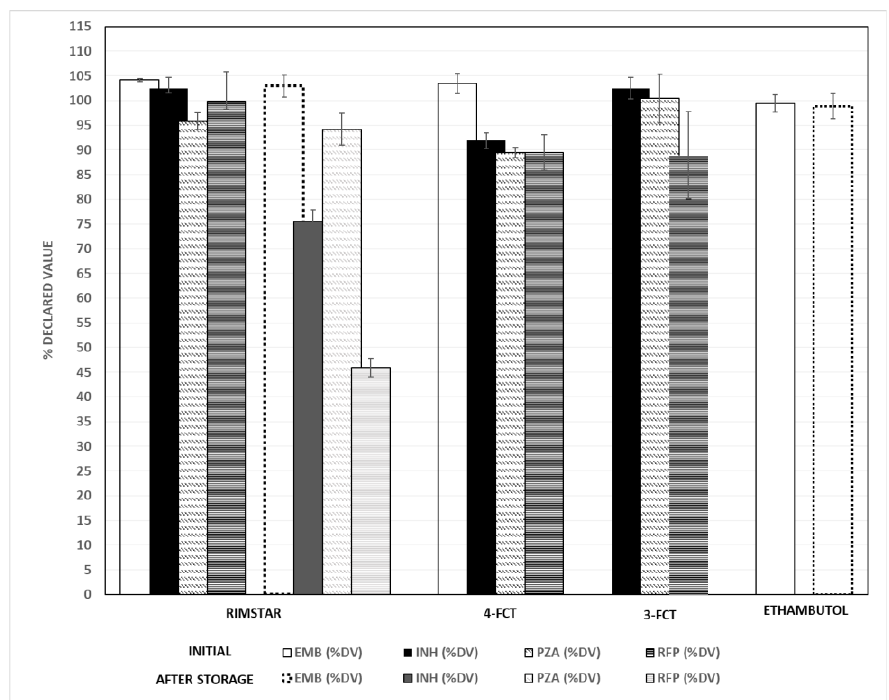
Figure 3. Percentage of API according to the declared content for each fixed-dose combination tablet (FCT) analyzed. DV: declared value, EMB: ethambutol, INH: isoniazid, PZA: pyrazinamide, RFP: rifampicin.